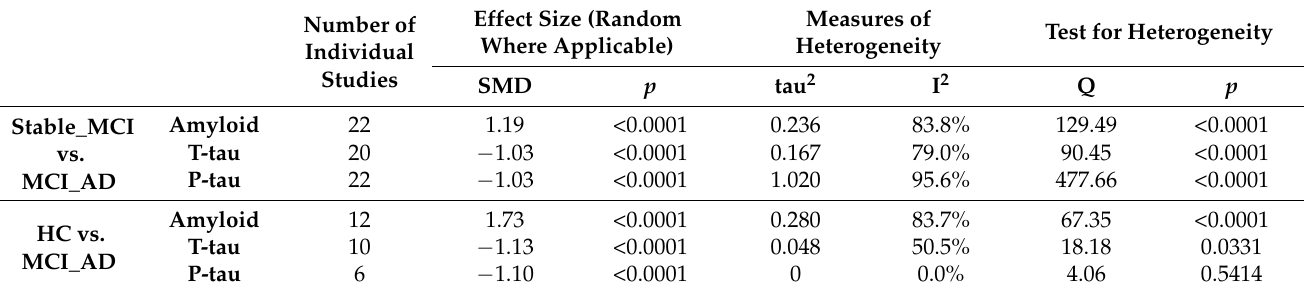
Table 1. Summary of key findings from the six meta-analyses described in Appendix A